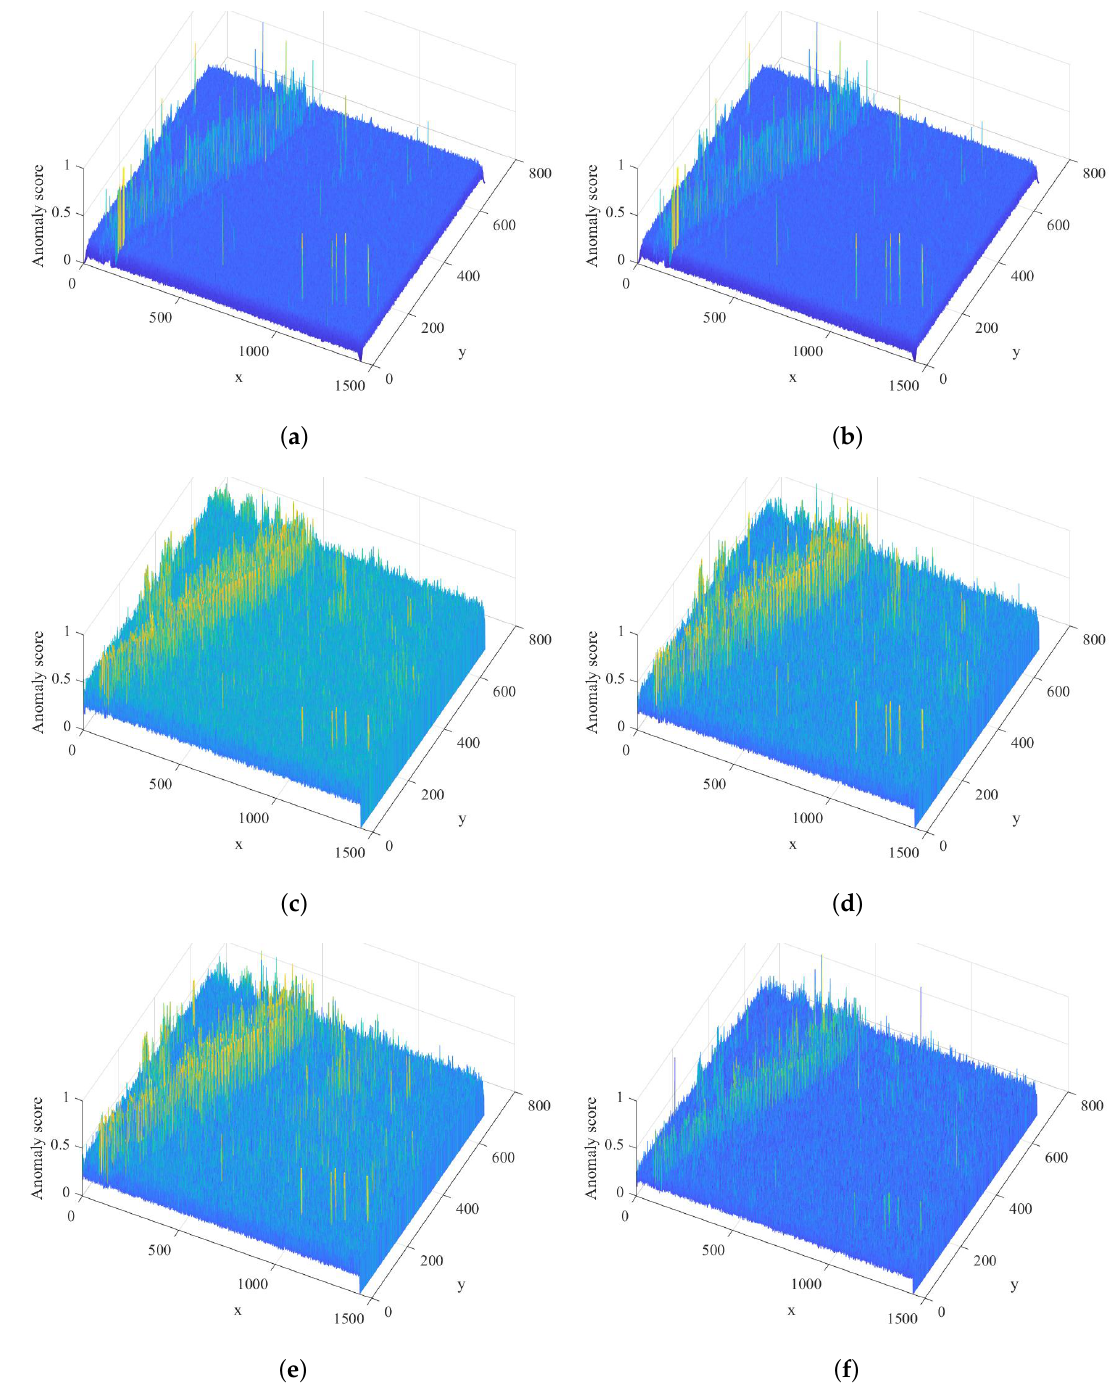
Figure 17. The detection results for Louisiana data set. ( a ) The anomaly score image of Louisiana by LRXD; ( b ) The anomaly score image of Louisiana by collaborative representation based anomaly detector (CRD); ( c ) The anomaly score image of Louisiana by floating point precision without pruning anomaly detectors (Floating-AD); ( d ) The anomaly score image of Louisiana by floating point precision with pruning anomaly detectors (Floating-AD)P-Floating-AD; ( e ) The anomaly score image of Louisiana by P-Fixed-AD; ( f ) The anomaly score image of Louisiana by